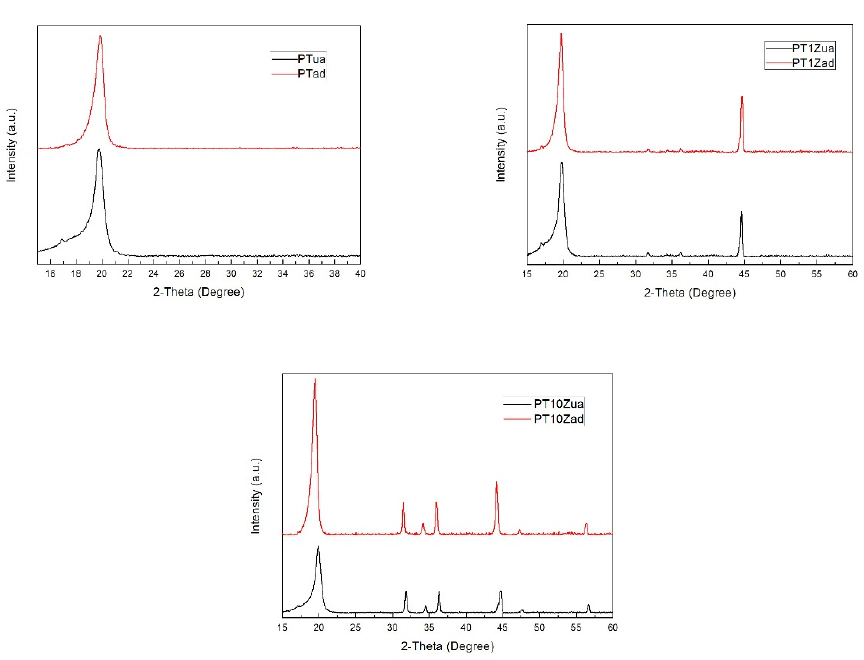
Figure 5. XRD diagrams for eight comparison groups.